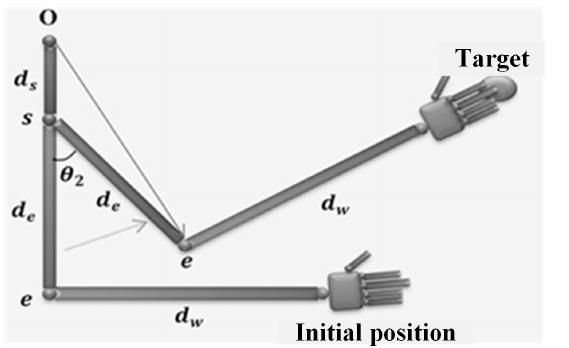
Figure 15. Joint θ 2 geometrical solution [39].